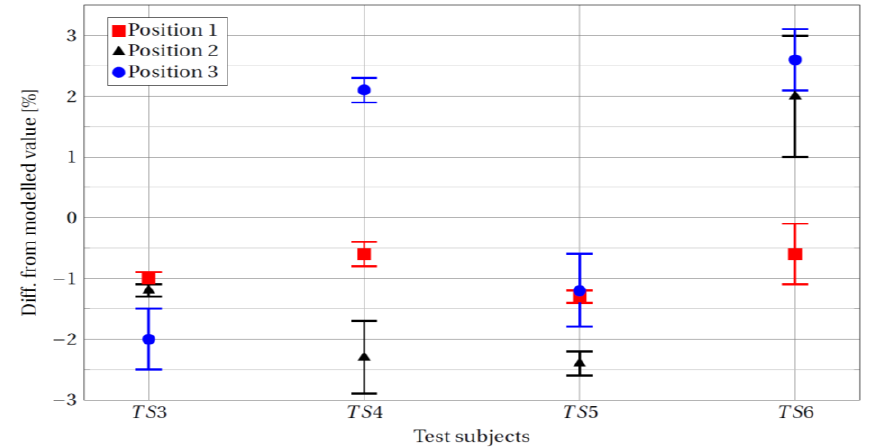
Figure 6. Percentage difference between the measured and the modelled C D A in three different positions, with error bars from the